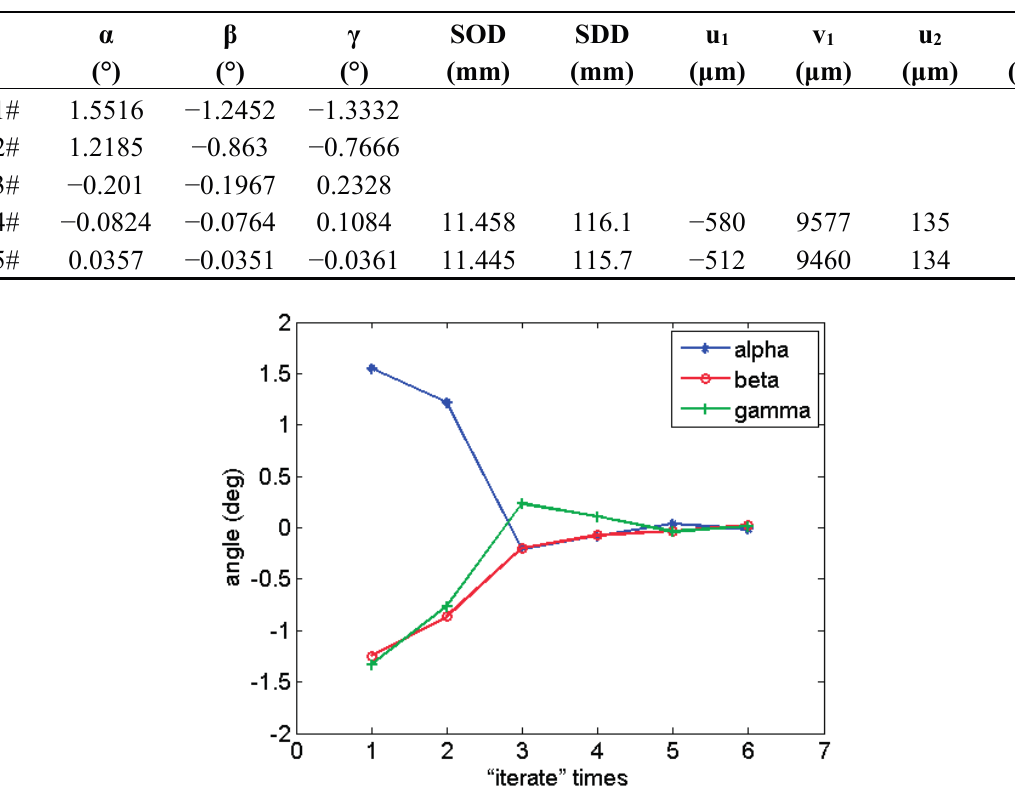
Table 4. Calibration results of all the parameters.